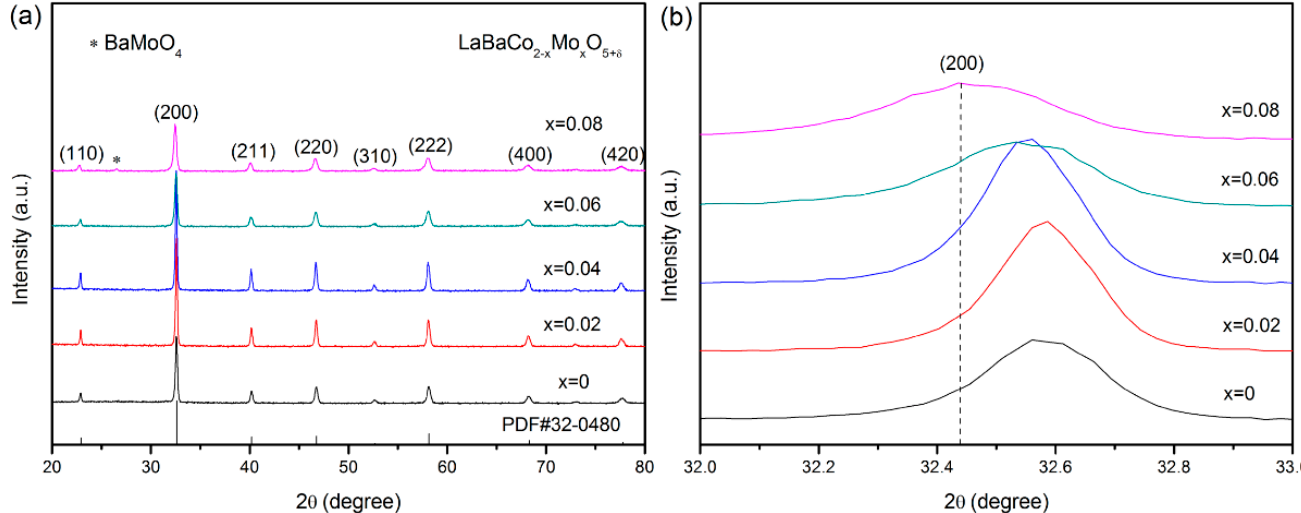
Figure 1. ( a ) XRD patterns of the synthesized LBCM x ( x = 0–0.08) powders. ( b ) Magnification of the patterns in the 2 θ range of 32° to 33°. patterns in the 2 θ range of 32 ◦ to 33 ◦